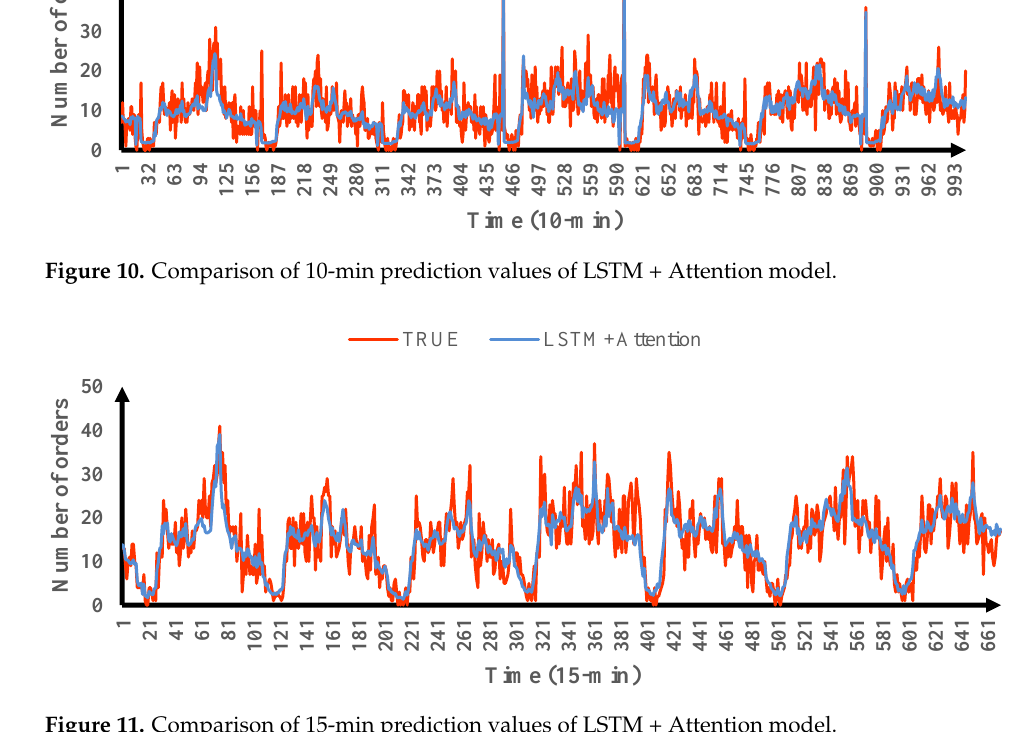
Figure 11. Comparison of 15-min prediction values of LSTM + Attention model.